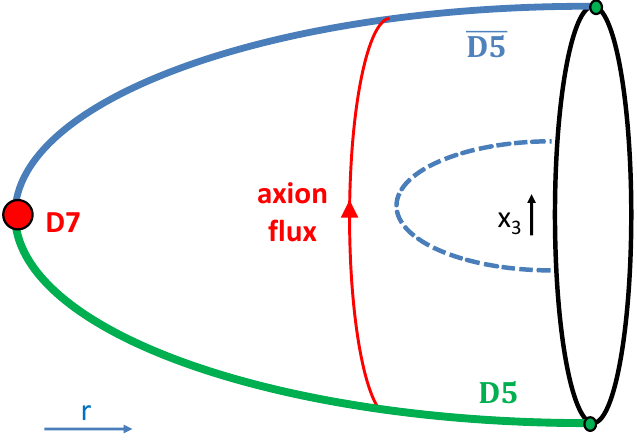
Figure 1. Holographic bulk dual of N = 4 SYM compacti(cid:12)ed on a circle with anti-periodic boundary conditions for fermions and a linear theta angle. Not displayed are the internal S 5 and the 3d Minkowski part of the spacetime. The N f (cid:13)avor D5 and anti-D5 branes extending from the boundary to the Hall D7 branes at the tip of the cigar are introduced in section 3. The dashed line corresponds to an alternate D5/anti-D5 embedding that is also discussed in section